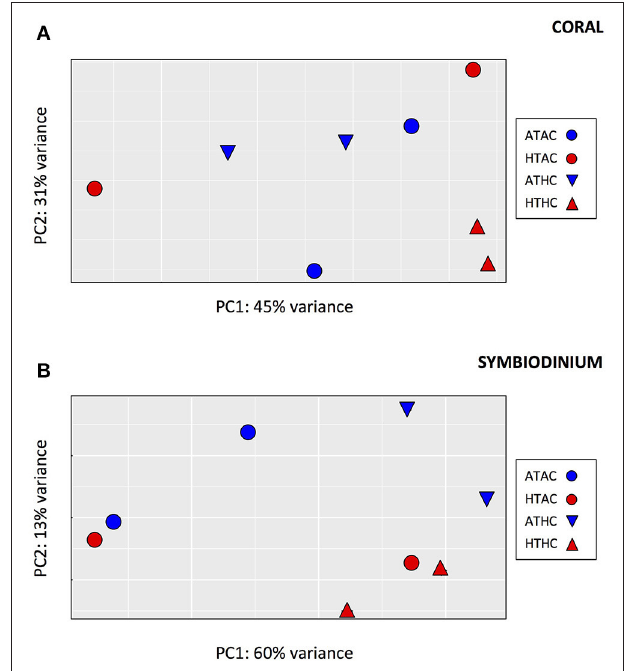
FIGURE 2 | Principal components analysis depicting global pattern of gene expression for transcripts from (A) coral host tissue and (B) Symbiodinium for each of four experimental treatments: Ambient-T, Ambient-pCO 2 (ATAC), High-T, Ambient-pCO 2 (HTAC), Ambient-T, High-pCO 2 (ATHC), High-T, High-pCO 2